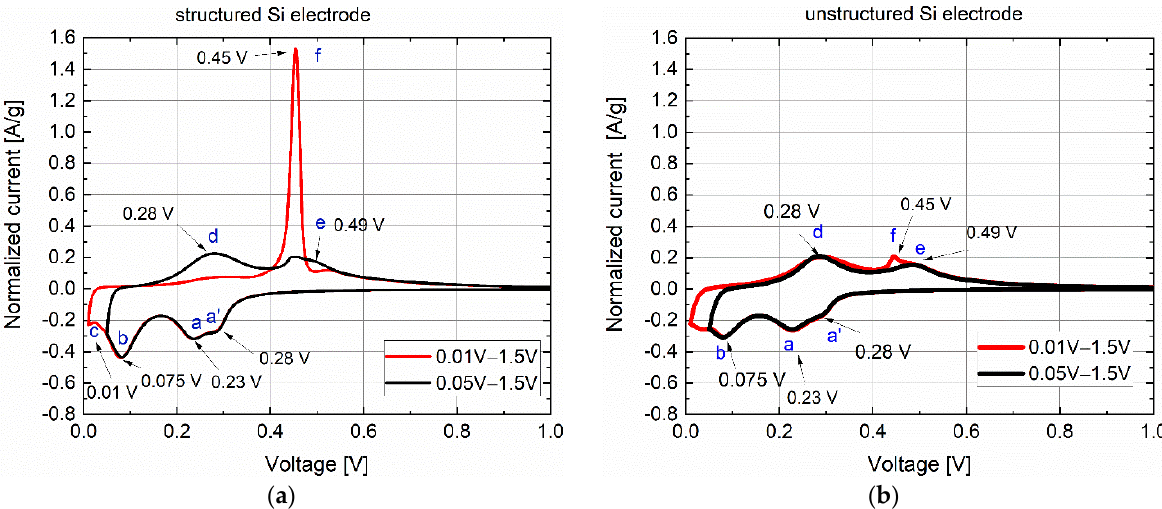
Figure 3. Cyclic voltammogram of cells with structured ( a ) and unstructured ( b ) Si electrodes rec- orded by a swap rate of 10 µV/s in a voltage window of 0.01–1.5 V and 0.05–1.5